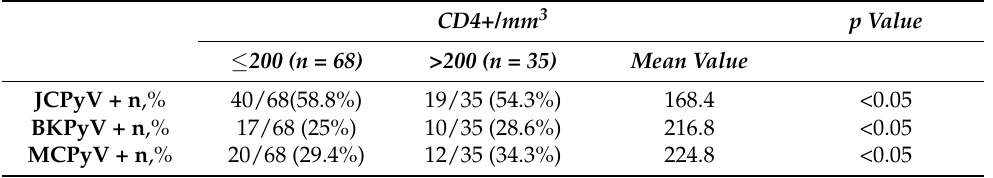
Table 6. Analysis of HPyVs detection in relation to CD4+ cell count.